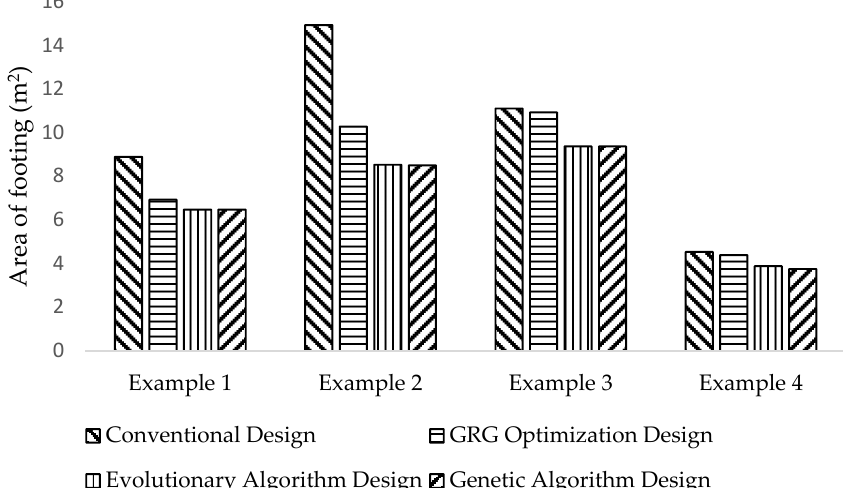
Figure 8. Comparison of area of the footing for examples 1–4.